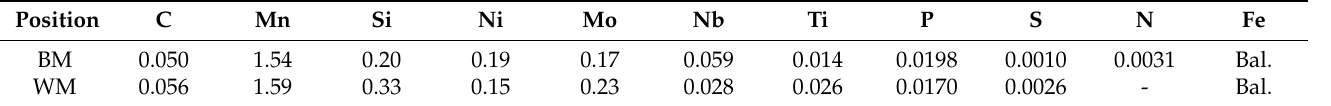
Table 1. Chemical composition of studied steel